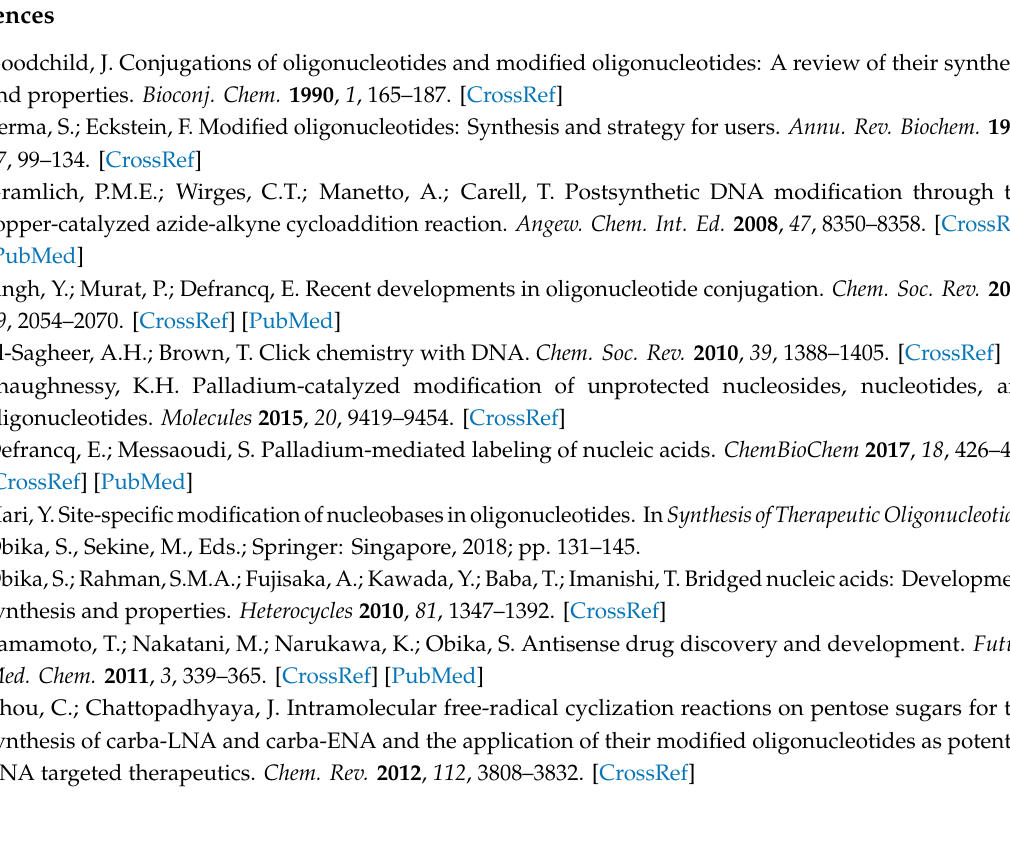
Supplementary Materials: The following are available online, Figure S1: An example of post-synthetic modification of ON2 , Figure S2: 1 H-NMR and 13 C-NMR spectra of compound 2 , Figure S3: 1 H-NMR and 31 P-NMR spectra of compound 3